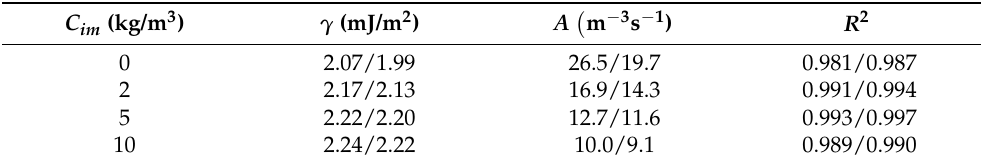
Figure 4. Plots of ln(∆𝑇 𝑚 2𝑏 + 𝑡 𝑖 ⁄ ) against ln 2 𝑆 𝑚 for various impurity concentrations, 𝐶 𝑖𝑚 , according to Equation (5) based on the induction time data with consideration of the lag time. Table 4. Calculated values of 𝛾 and 𝐴 with the regression coefficients, 𝑅 2 , based on the induction time data. The number before the slash represents the value without consideration of the lag time and the number after the slash represents the value with consideration of the lag time.